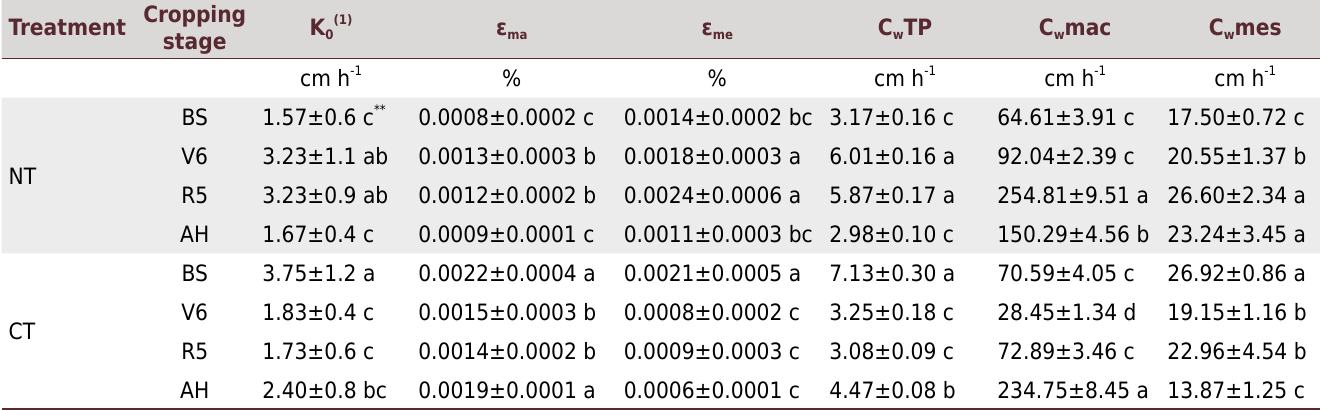
Table 3. Dynamic SPQ indicators (mean values and standard deviations) for the different treatments (NT, CT) and cropping stages of the corn growing season (BS, V6, R5, and AH) Cropping Treatment